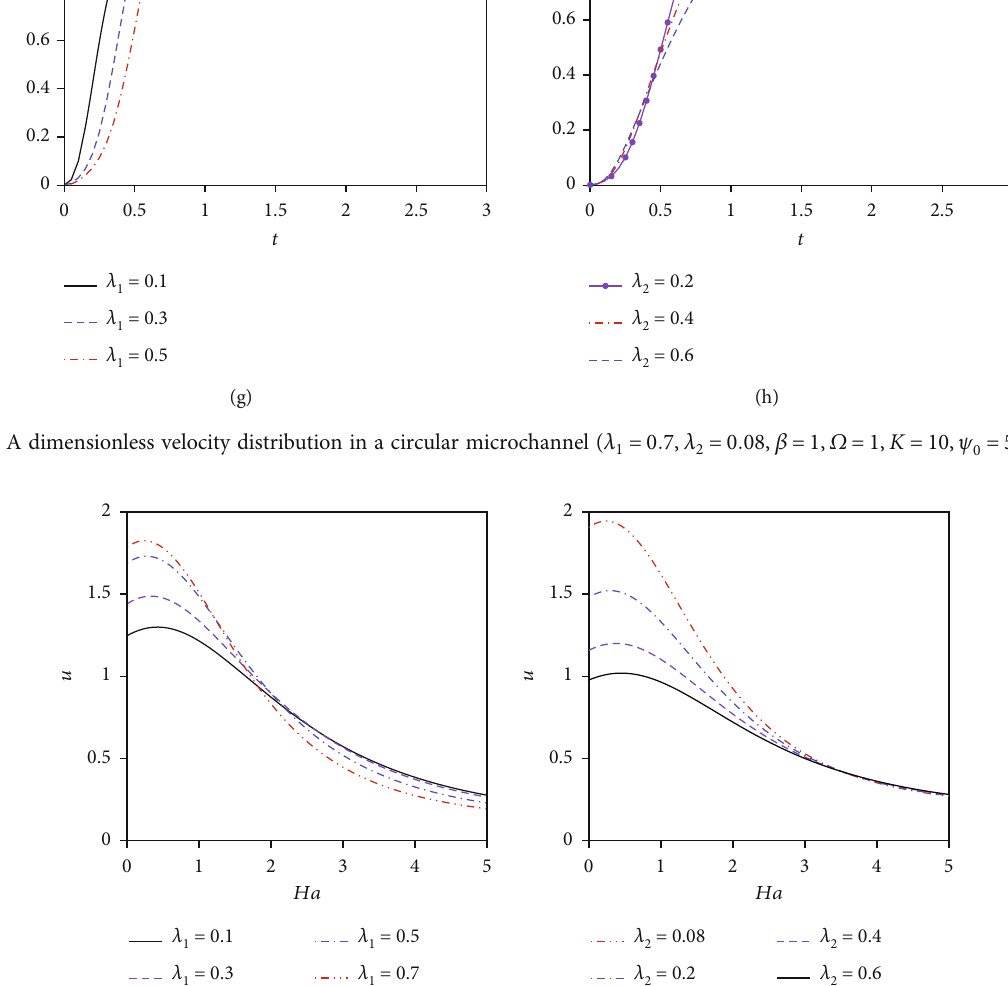
= 0 : 7 ð b Þ , λ = 0 : 08 ð a Þ , β = 1, Ω = 1, K = 10, ψ 1 2